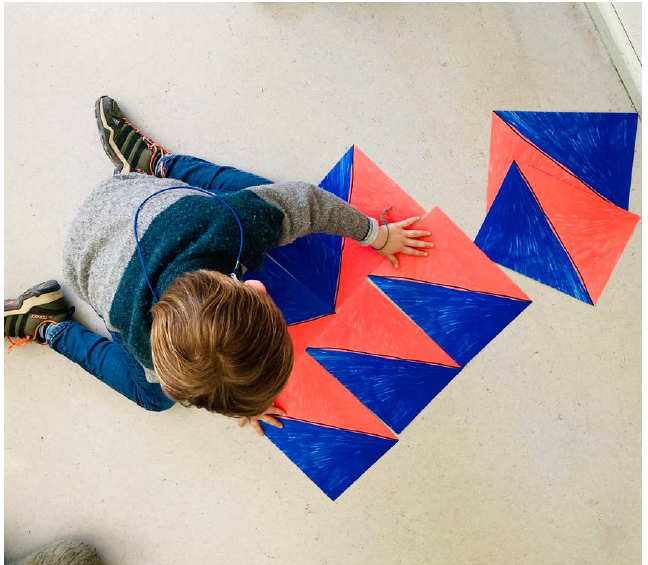
Fig. 8 Photo by Giulia